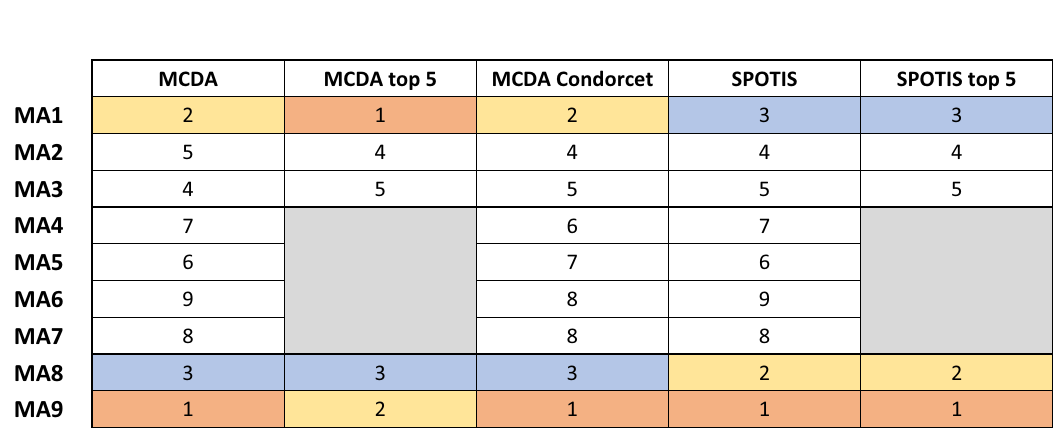
Table 6. Summary rankings of MCDA, MCDA top 5, MCDA Condorcet, SPOTIS, and SPOTIS top